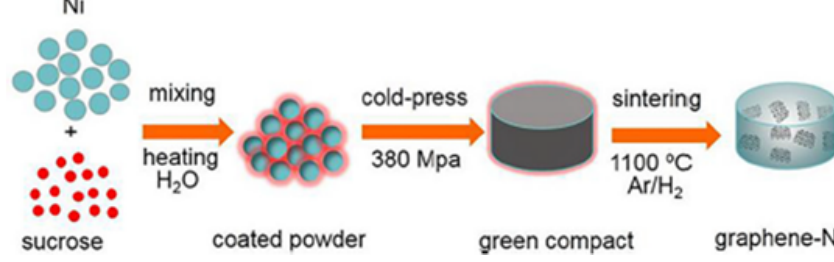
Figure 13: A schematic diagram of the in-situ fabrication process of Gr-Ni composite. Reproduced from Reference